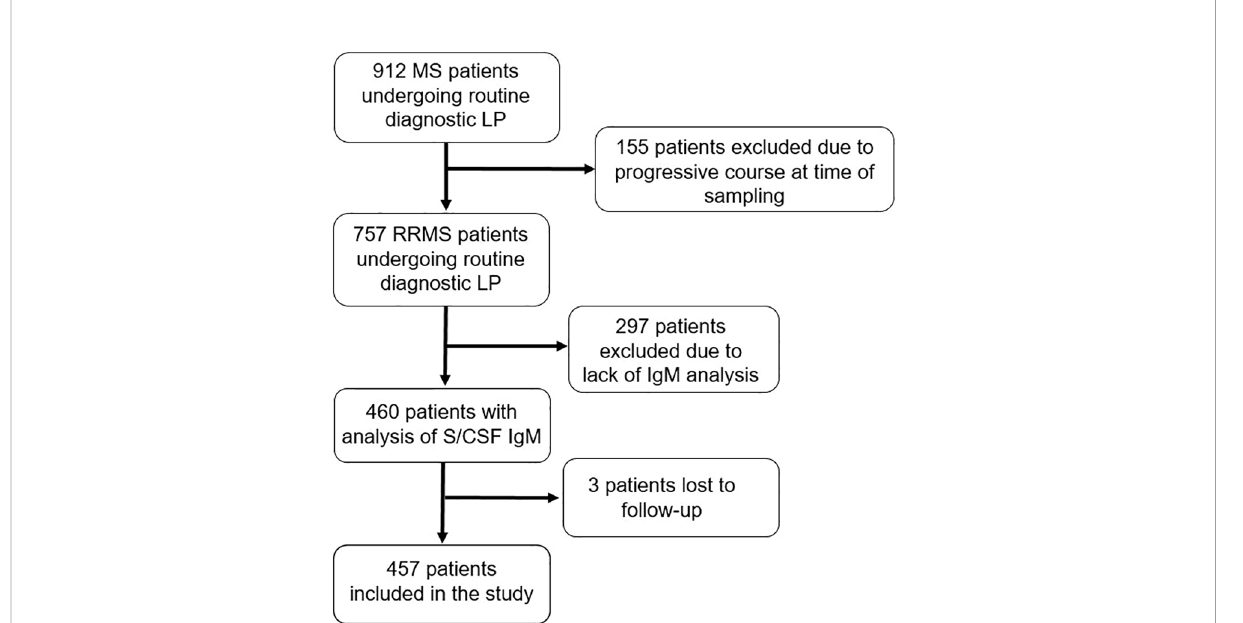
FIGURE 1 Flow chart of the selection of patients with relapsing-remitting multiple sclerosis ful fi lling study criteria. MS, multiple sclerosis; LP, lumbar puncture; RRMS, relapsing-remitting MS; IgM, immunoglobulin M; S, serum; CSF, cerebrospinal fl